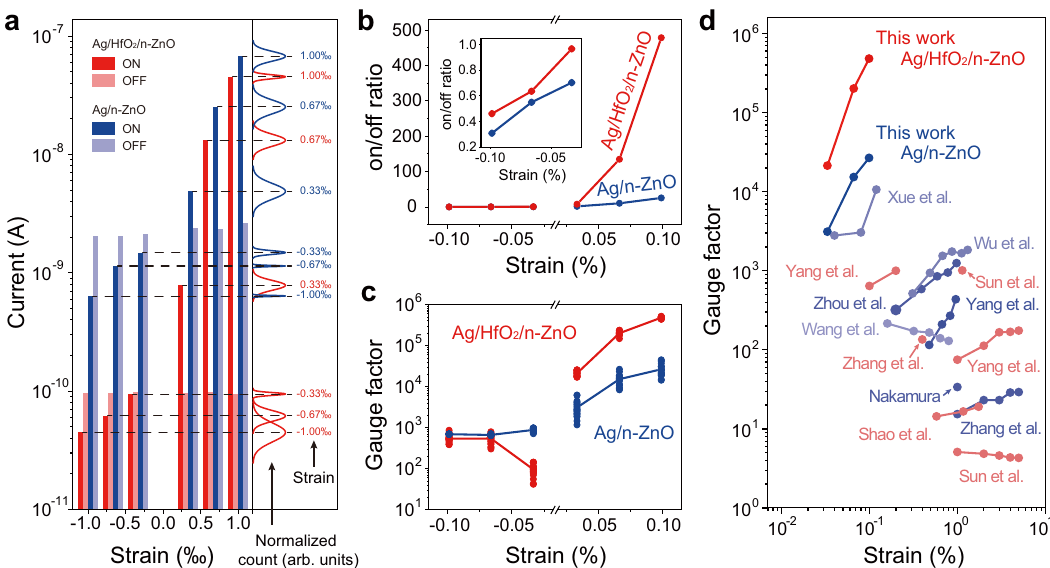
Fig. 5 Strain-sensing performance of the Ag/HfO 2 /n-ZnO PTSS and the Ag/n-ZnO SSS. a Statistical distributions and histograms of the “ ON ” state and “ OFF ” state current of the Ag/HfO 2 /n-ZnO PTSS and Ag/n-ZnO SSS upon compressive and tensile strains. b , c On/off ratio ( b ) and gauge factor ( c ) of Ag/HfO 2 /n-ZnO PTSS and Ag/n-ZnO SSS as a function of applied strain derived from a . d Comparison of the gauge factor of this work (including Ag/ HfO 2 /n-ZnO PTSS and Ag/n-ZnO SSS) with some existing ZnO nanowire or nanobelt based